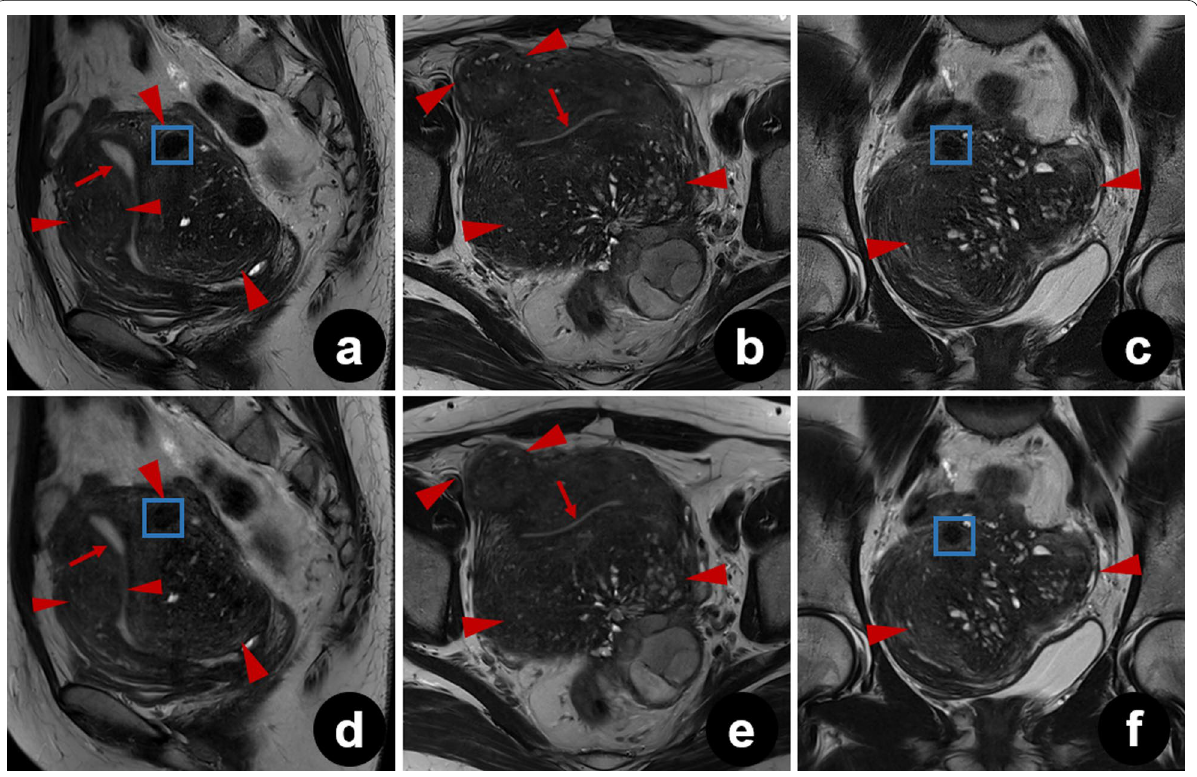
Fig. 6 Pelvic T2 DL and T2 S images of a 43‑year‑old female patient with diffuse adenomyosis. Sagittal ( a ), axial ( b ), and coronal ( c ) T2 DL images and sagittal ( d ), axial ( e ), and coronal ( f ) T2 S images. Typical findings of asymmetry of uterine wall thickness, poorly demarcated low‑SI area, and intramyometrial cysts are presented. Compared to T2 S images, T2 DL images exhibited greater conspicuity of the lesions (between arrowheads) and uterine zonal layers (arrows). Note that a small leiomyoma is also observed more clearly on sagittal and coronal T2 DL images (frame) than on the